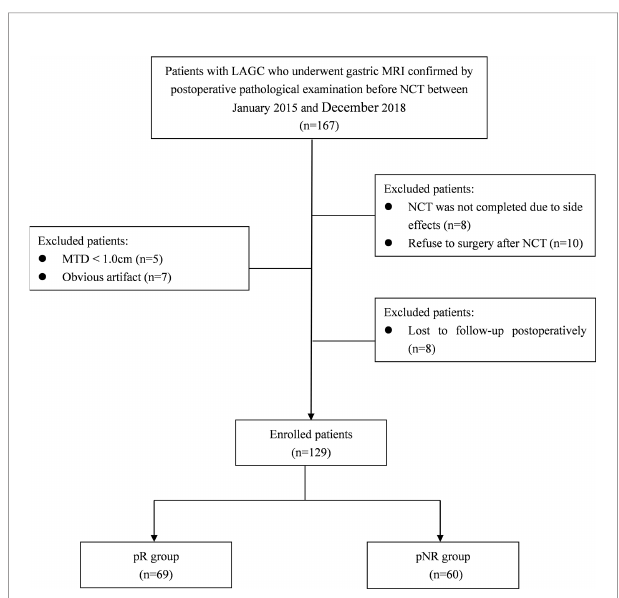
FIGURE 1 | Diagram showing the recruitment of the study population and exclusion criteria. LAGC, locally advanced gastric cancer; NCT, neoadjuvant chemotherapy; MTD, maximum tumor diameter; pR, pathological responders; pNR, pathological